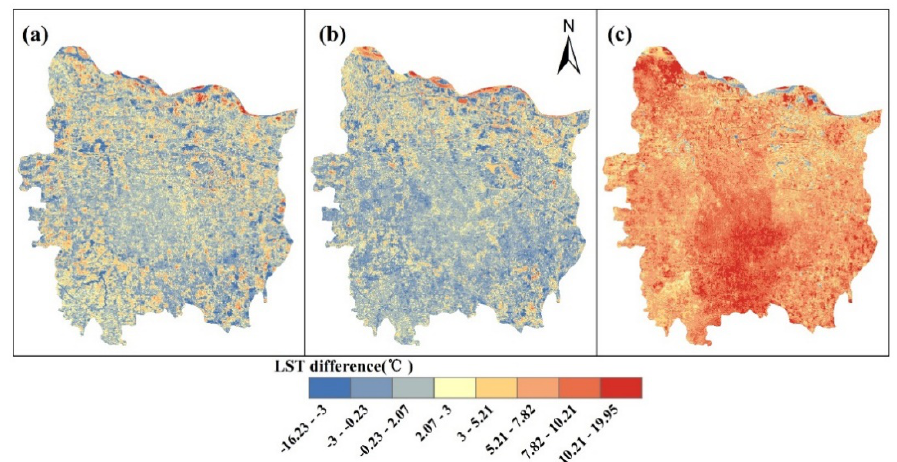
Figure 18. Difference between Landsat LST (28 June 2013) and three predicted “Landsat-like” LST generated by using one single input MODIS LST (28 June 2013) and three different pairs of inputs (MODIS LST and Landsat LST) on different dates: 11 May 2013 (a), 4 June 2013 (b), and 31 August 2013 (c).